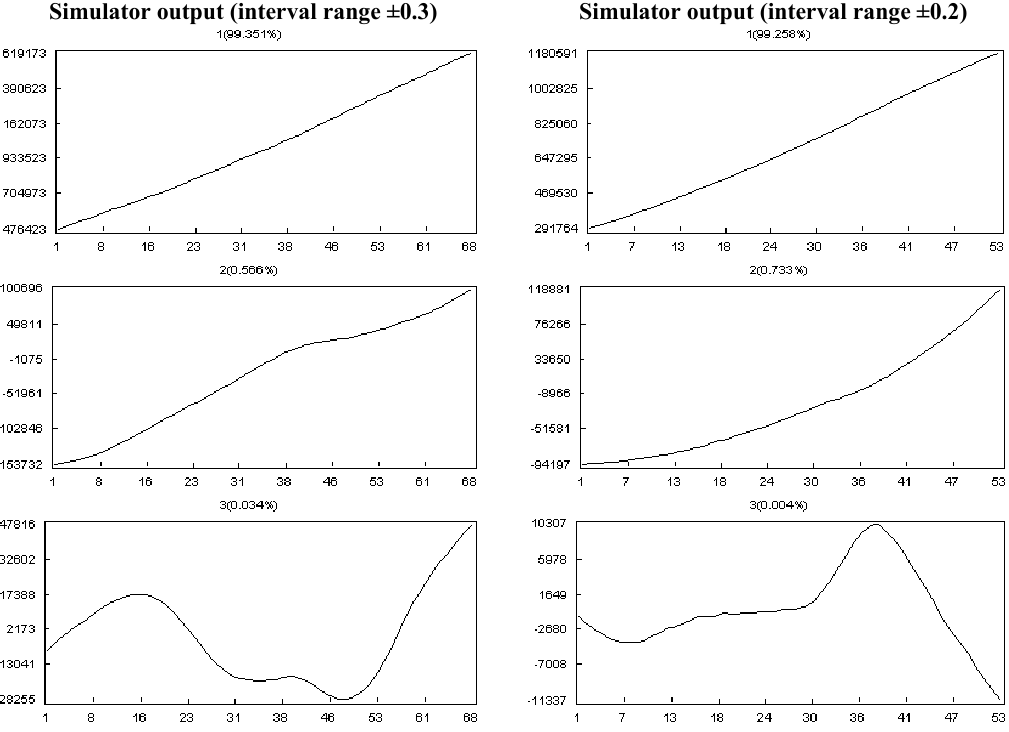
Figure 19. Principal components related to the first three eigentriples of the time series for two different interval ranges.